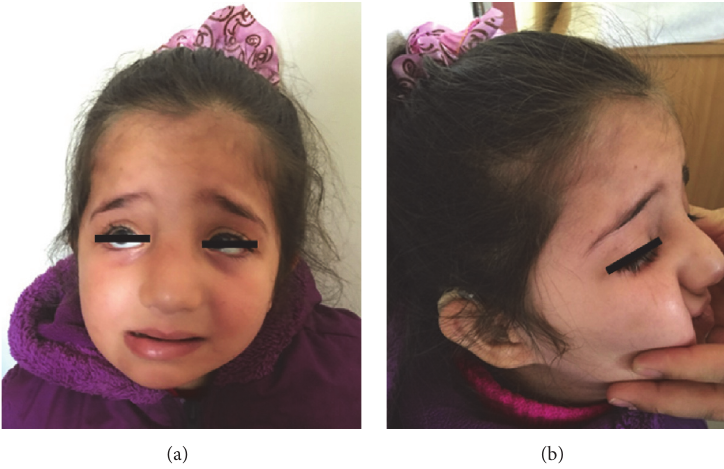
Figure 3: Dysmorphic facial features in Case